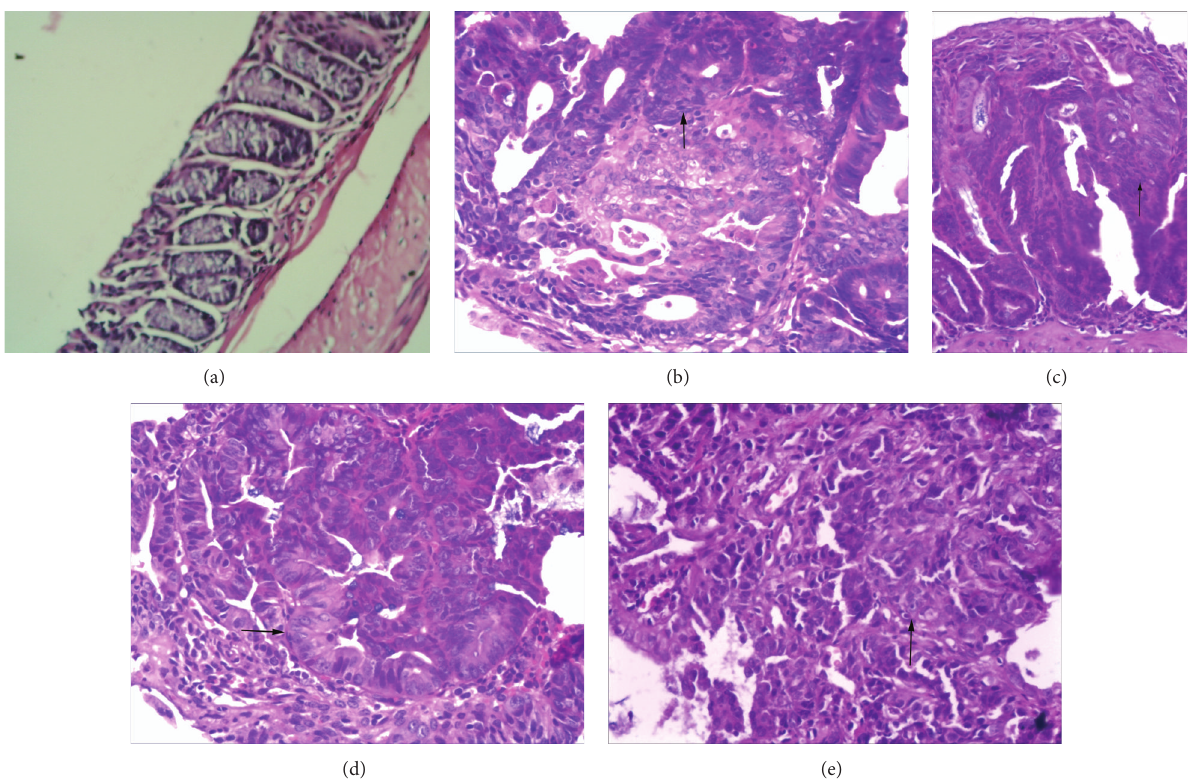
Figure 2: Photograph presentation of histological change of dysplasia in the bowels taken from ICR mice dosed with DMH and DSS over the examined time-points. The images from H&E stained slides showed that tumors were not observed in the controls (Figure 2(a)). However, dysplastic lesion was observed after induction for 14 weeks (arrow pointed in Figure 2(b)); the degree of dysplasia was further increased after induction for 16 weeks (arrow pointed in Figure 2(c)) and 18 weeks (arrow pointed in Figure 2(d)) and finally became cancerous lesion after